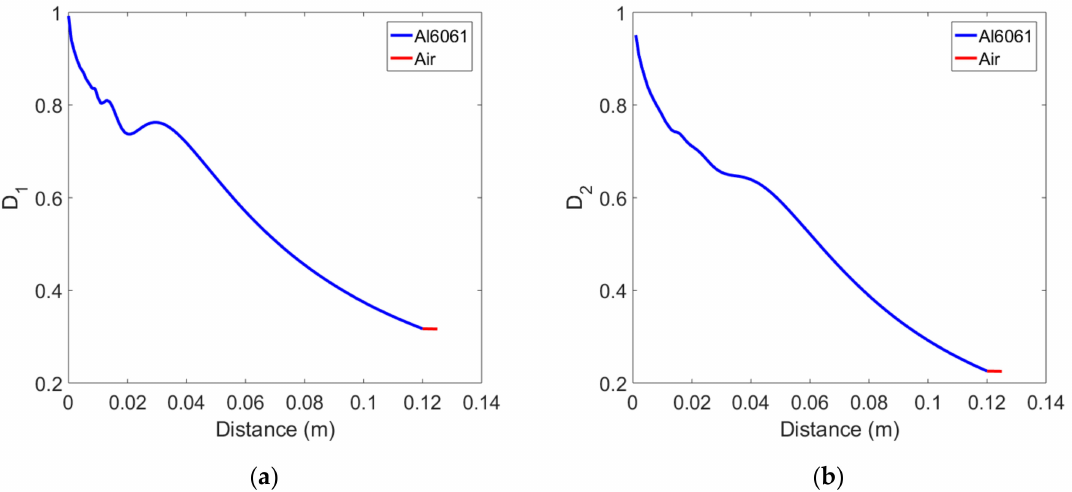
Figure 3. Variation of diffraction correction in the two-layer medium composed of solid and air: ( a ) Fundamental wave, and ( b ) Second harmonic wave.